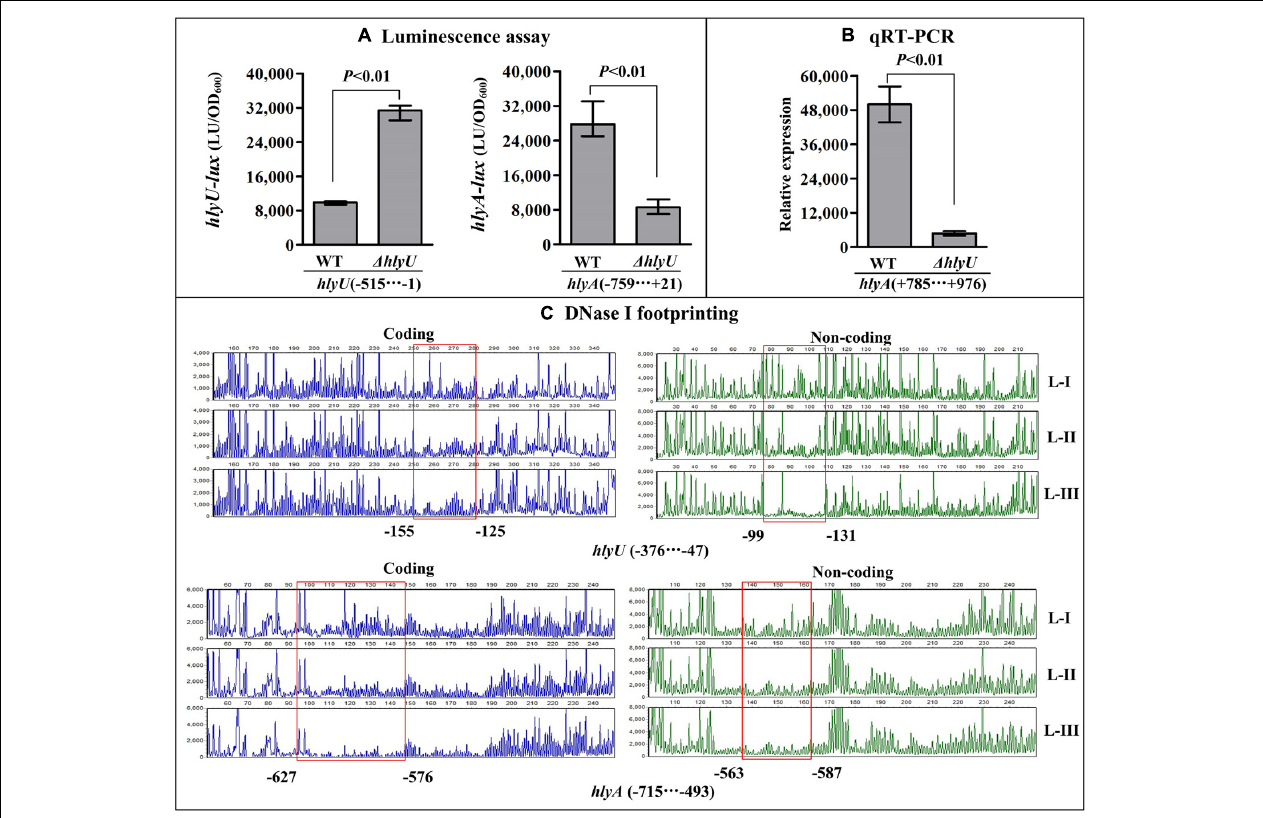
FIGURE 3 | Regulation of hlyU and hlyA by HlyU. The luminescence assay (A) was done as Figure 2 . (B) qRT-PCR. The relative mRNA level of fur was compared between (cid:49) hlyU and WT. (C) DNase I footprinting. The promoter fragment of each target gene was labeled with FAM or HEX, incubated with increasing amounts of purified His-HlyU (Lanes-I, II, and III contain 0, 4.06, and 12.12 pmol, respectively), and then subjected to DNase I footprinting assay. The results were analyzed using an ABI 3500XL DNA analyzer. The protected regions are boxed and marked with positions. The negative and positive numbers indicate the nucleotide positions relative to the translation start site (+1) of each target genes,